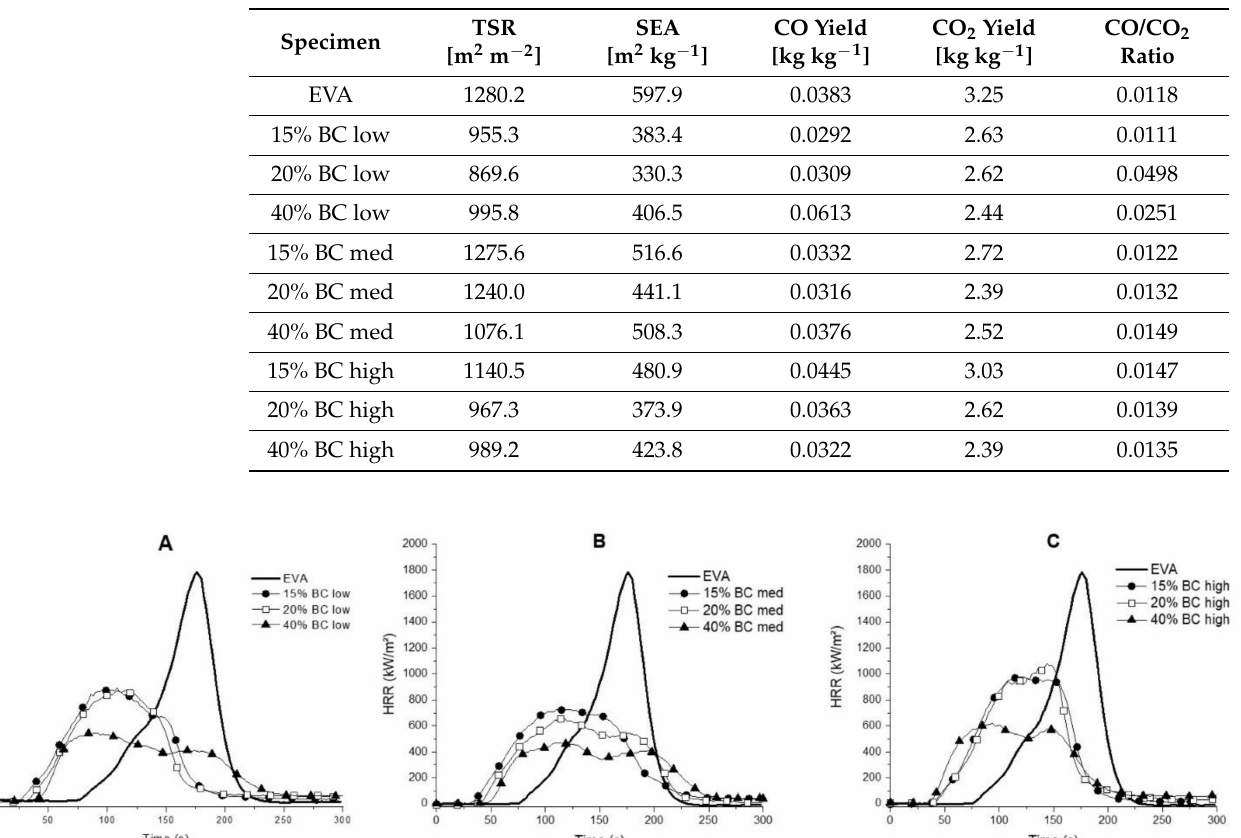
Table 4. Main smoke parameters by cone calorimetry tests.